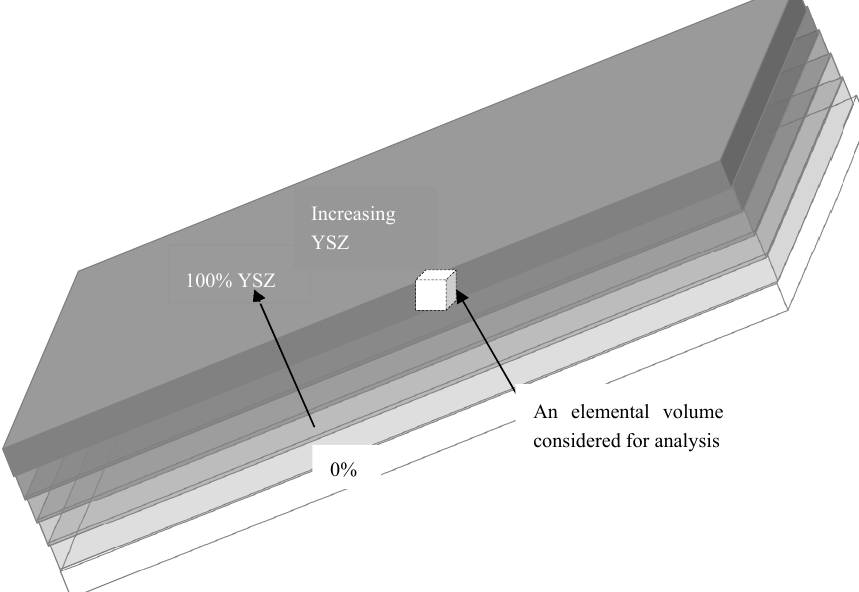
Figure 7. 3D schematic view of multilayers in BC-YSZ FGTBC systems. Individual layers are separated with well-defined interfaces (BC-bond coat, YSZ-yittria stabilized zirconia as top insulating coat).